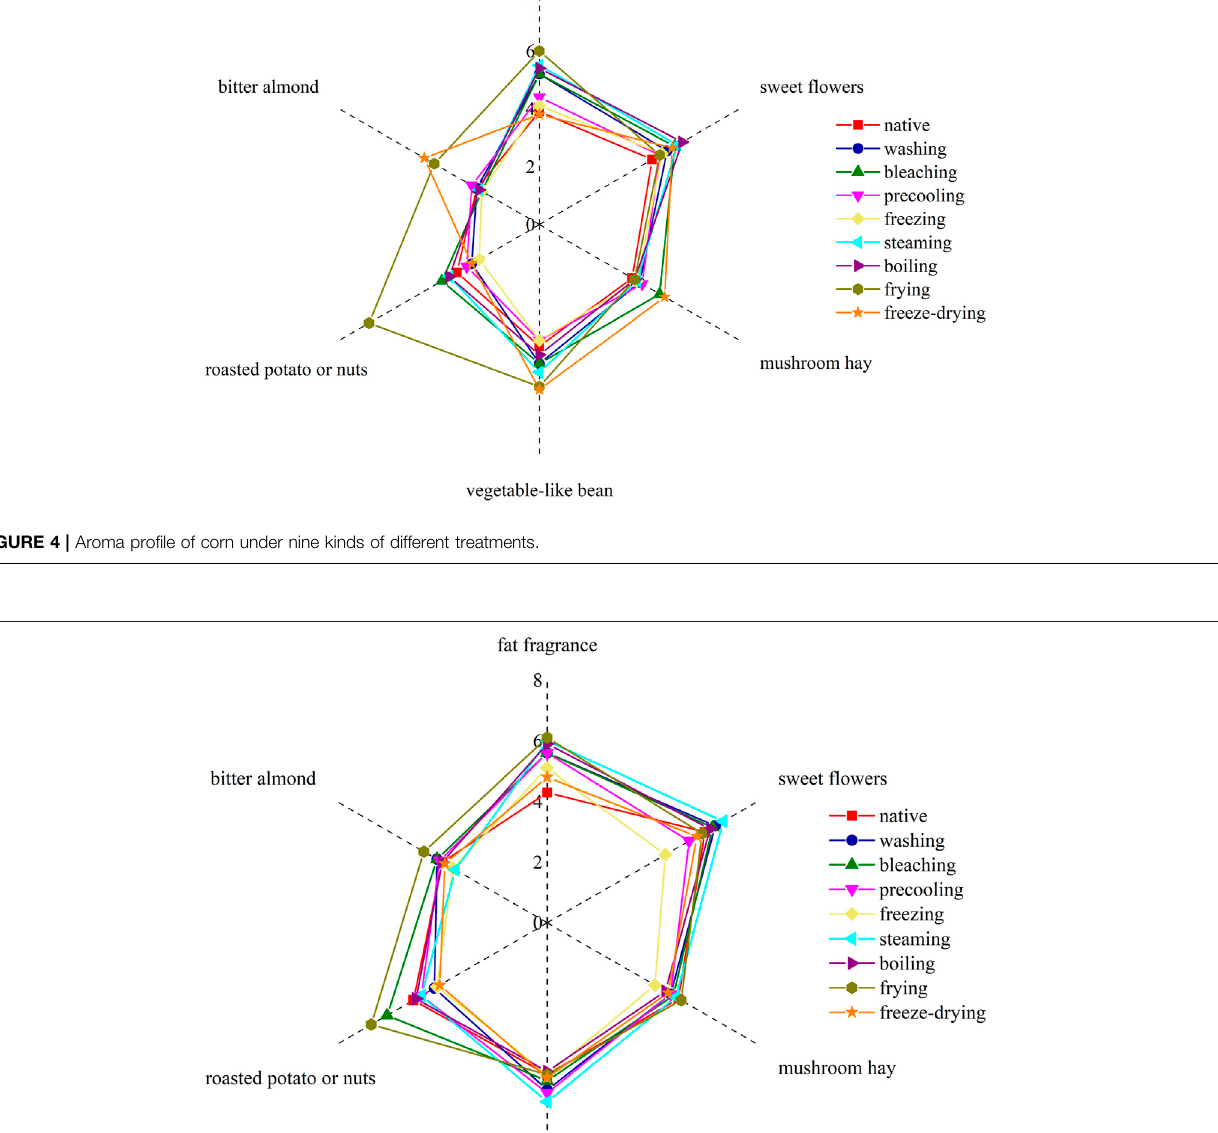
Frontiers in Chemistry |